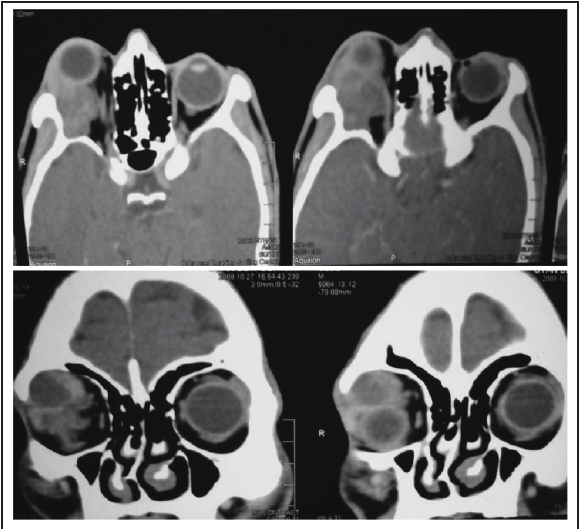
Figure 2. CT axial and coronal section of the brain and orbit showing heterogenously enhancing attenuated extraconal mass measuring 30.5mmx23.5mm in size in superolateral quadrant of the right orbit with small faint calcification within it. Right lacrimal gland is not seen separated from this mass.